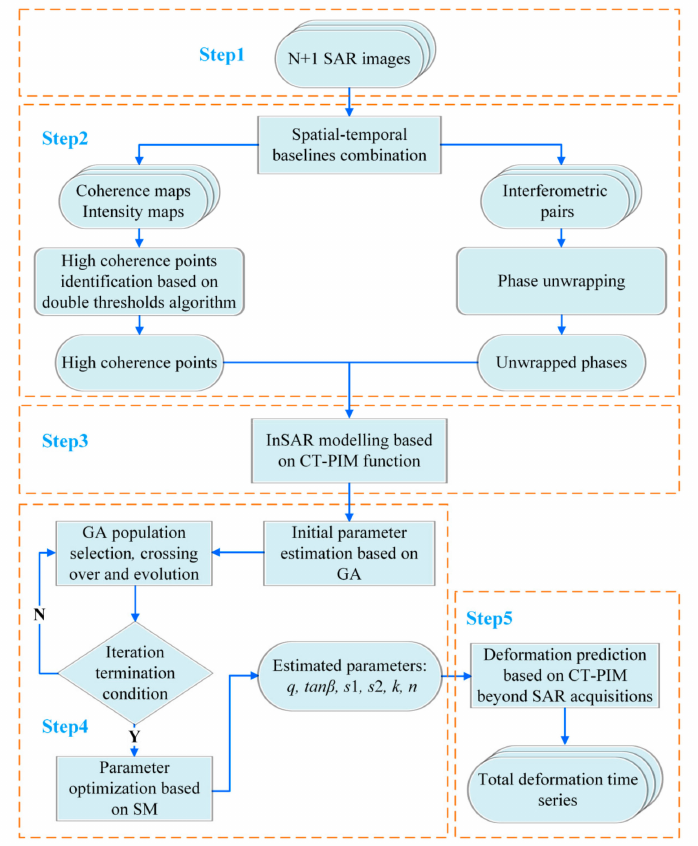
Figure 2. Flow chart of deformation prediction based on CT-PIM